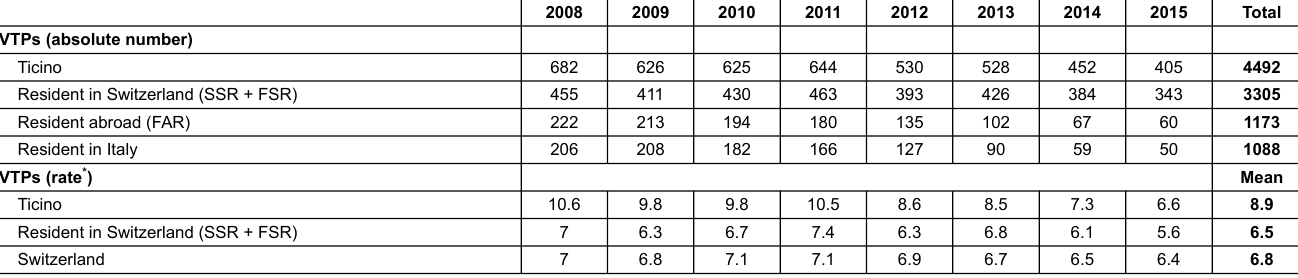
Table 2: Number and rate of abortions from 2008 to